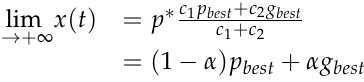
Figure 3. Flowchart of PSO algorithm.